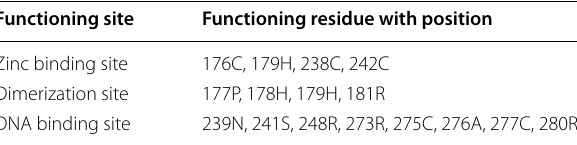
Table 7 Functional residues in different functioning sites of p53 protein Functioning